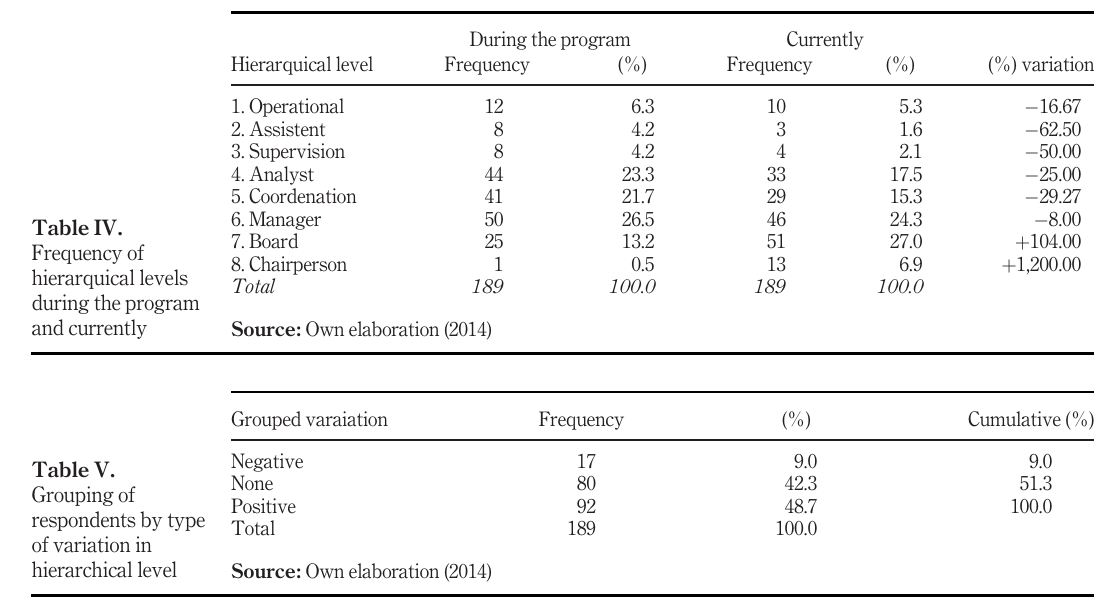
During the program Currently Frequency